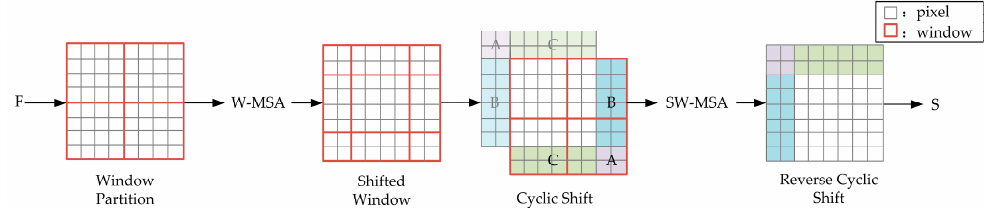
Figure 3. Multi-headed self-attention based on shifted windows.